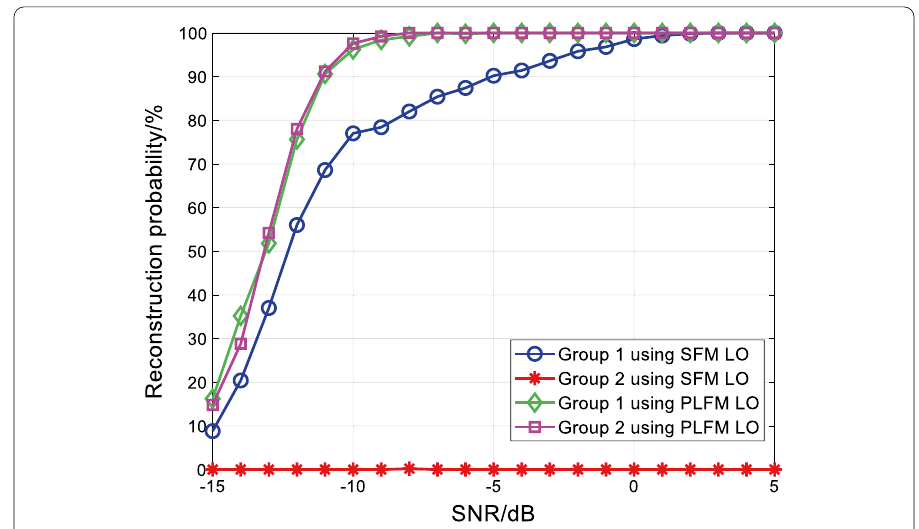
Fig. 6 Reconstruction probabilities of signals in two